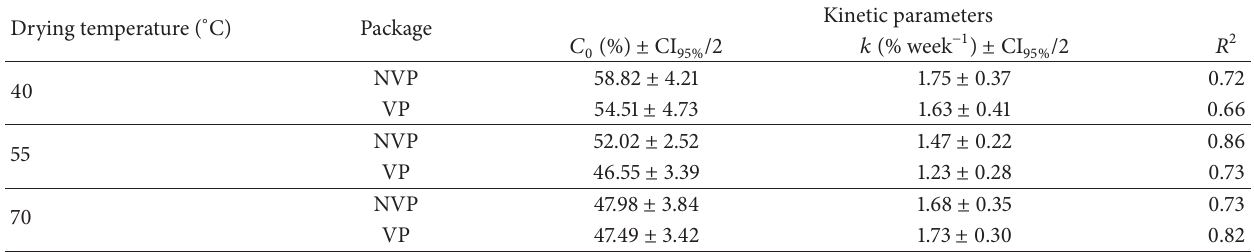
Table 1: Estimates of model parameters (with confidence intervals at 95%, CI 95 degradation during 5 months of storage, for galega kale dried at different temperatures and packed with vacuum (VP) and without vacuum